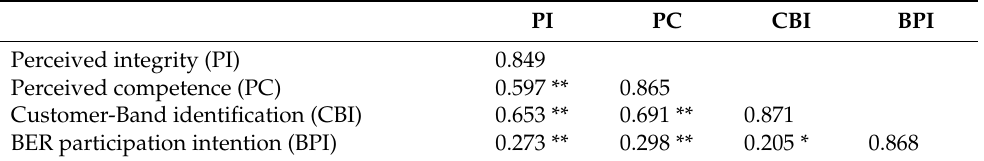
Table 2. Correlations of the